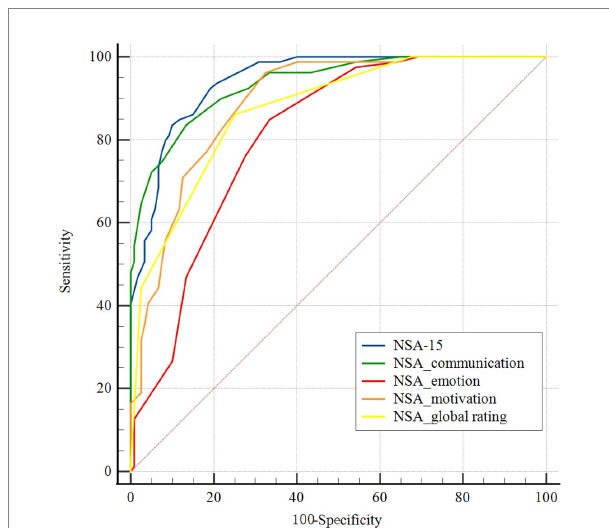
FIGURE 1 Receiver-operating characteristic (ROC) curves of cutoff scores on the negative symptom assessment (NSA-15), its three factors and the global rating. Blue: the NSA-15; green: NSA-15 communication factor; red: NSA-15 emotion factor; orange: NSA-15 motivation factor; and yellow: NSA-15 global